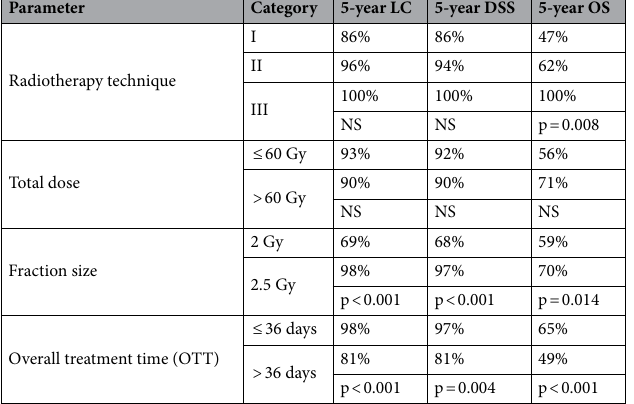
Table 2. The results of univariate analysis of correlations between selected radiotherapy parameters in relation to 5-year local control (LC), disease-specific survival (DSS), and overall survival (OS). NS no significance.